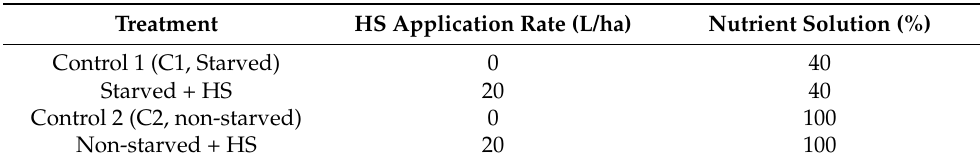
Table 1. Humic substance application rates (L/ha) and nutrient solution (%) applied to the plant sample